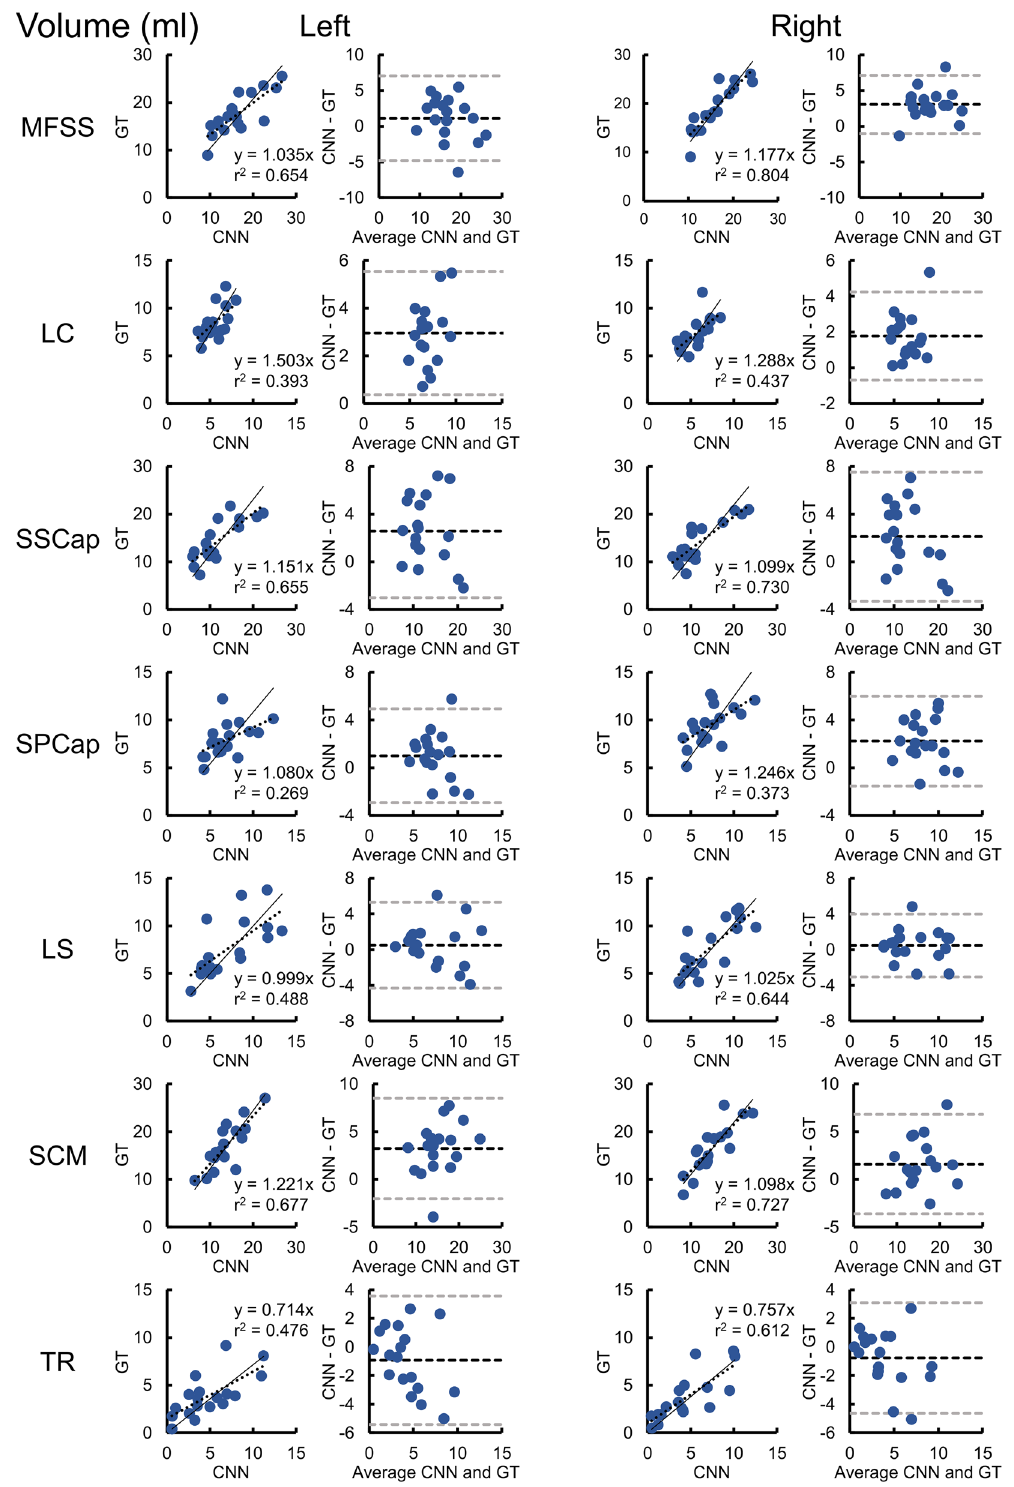
Figure 4. Reliability and accuracy of the convolutional neural network (CNN) muscle volumes on the testing dataset (n = 18). Correlation and Bland-Altman plots are shown for volume for each of the muscle groups. In the correlation plots, the dashed black line represents the best fit line, and the linear regression coefficient (β) of the ground truth (GT) on CNN (intercept = 0) is also provided (solid black line), which can be used to correct the CNN measurement bias. In the Bland-Altman plots, the dashed black and gray lines indicate the mean difference (i.e., bias) ± 1.96 × standard deviation (i.e., 95% limits of agreement). See Table 3 for the intraclass correlation coefficients (ICC 2,1